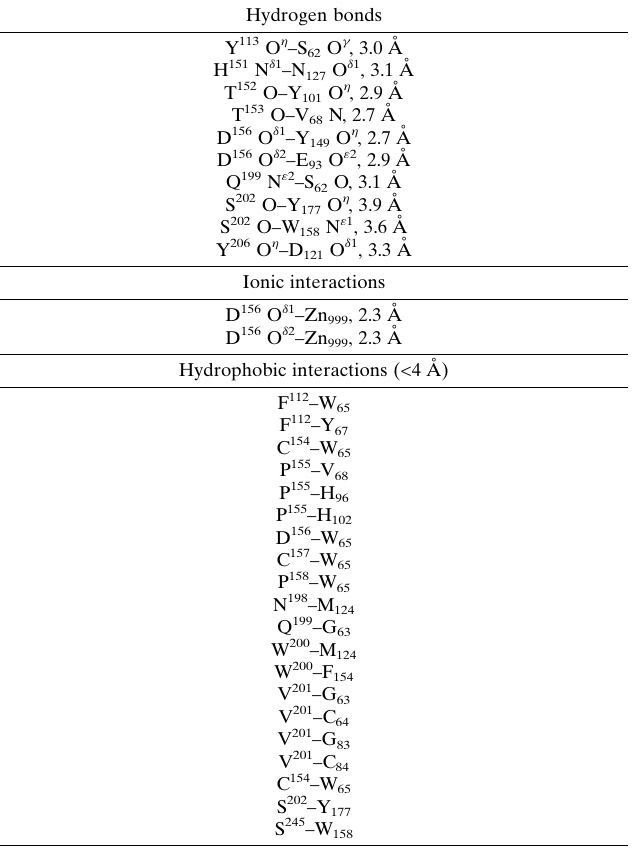
Table 2 Interactions at the astacin–fetuin-B interface. The first residue/atom belongs to fetuin-B and the second to astacin. The overall resolution of the structure is 3.1 A˚ , the estimated overall average coordinate error is 0.42 A˚ based on the Luzzati plot, and the dispersion precision indicator based on the free R factor is 0.49 A˚ . Thus, the distances are